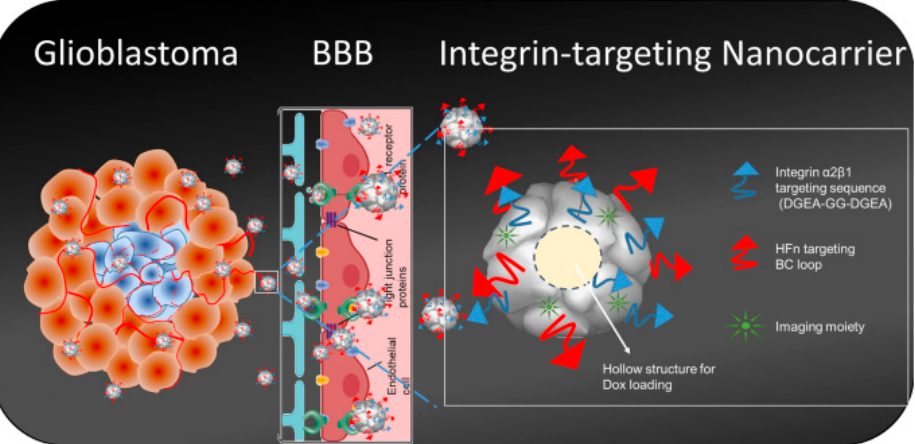
Figure 2. Ferritin nanoparticles for glioblastoma treatment. Targeted delivery of 2D-HFn to glioma through the BBB. Reprinted with permission [57] (CC BY 4.0).